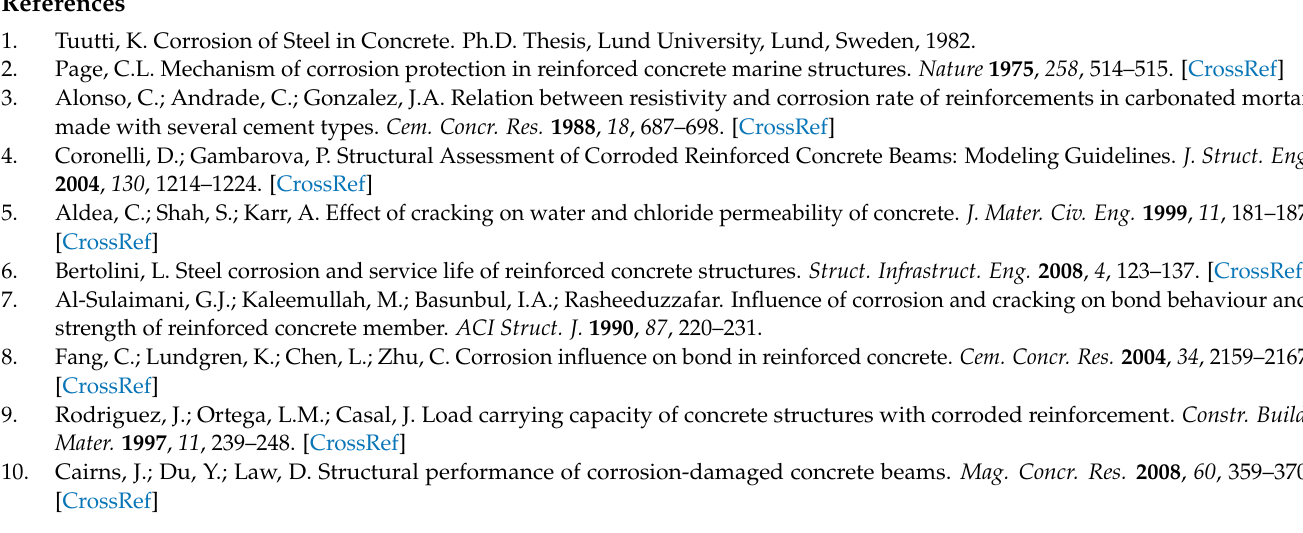
Figure A1. Comparison of separated and homogenized concrete modeling.